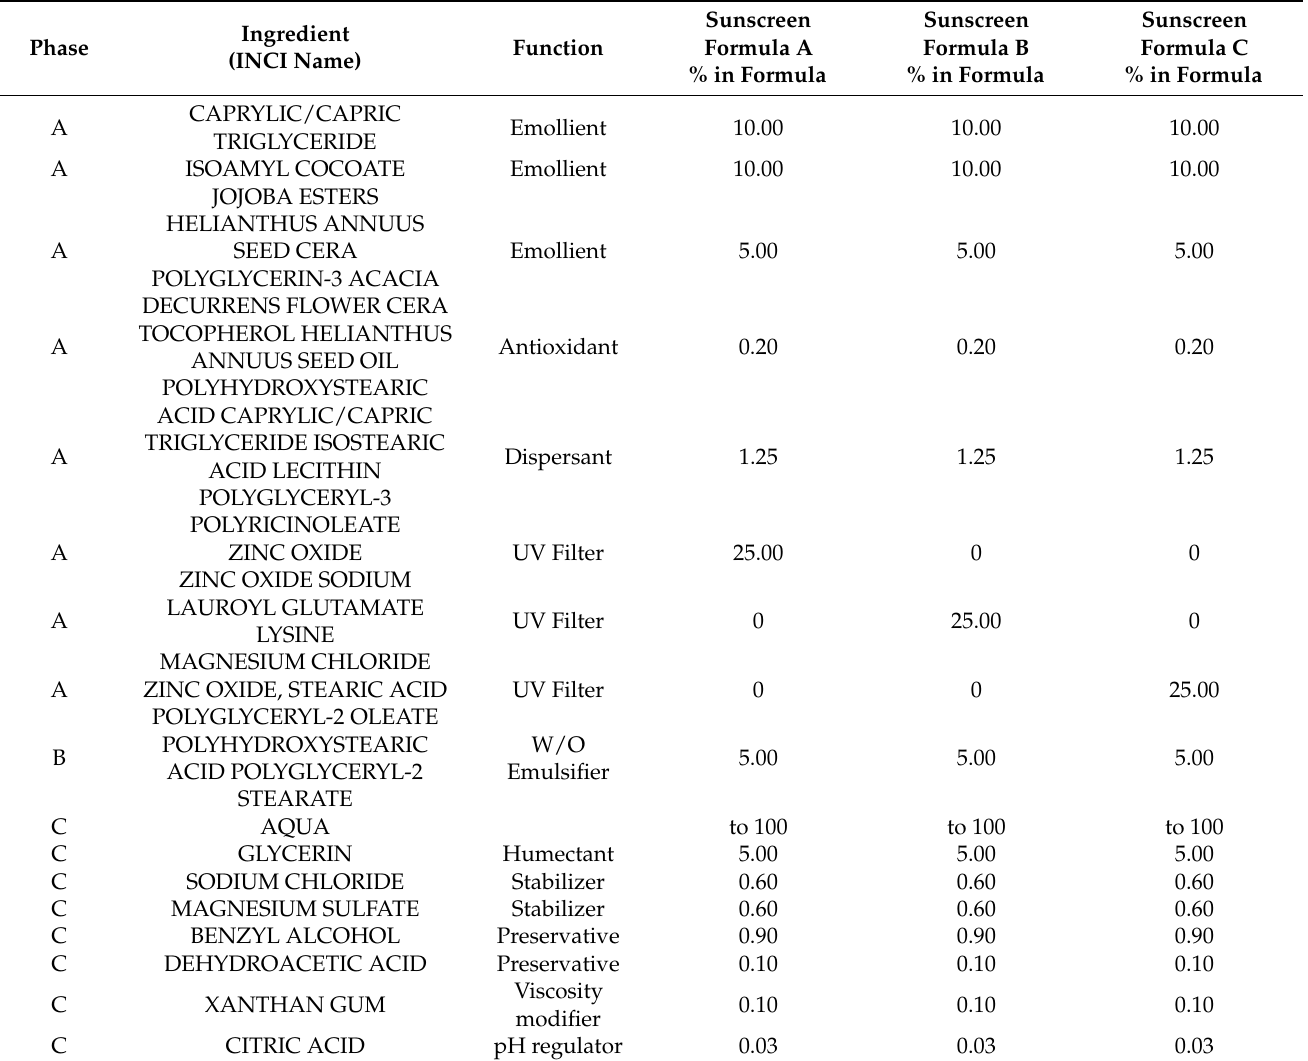
Table 2. Sunscreen formulas A, B and